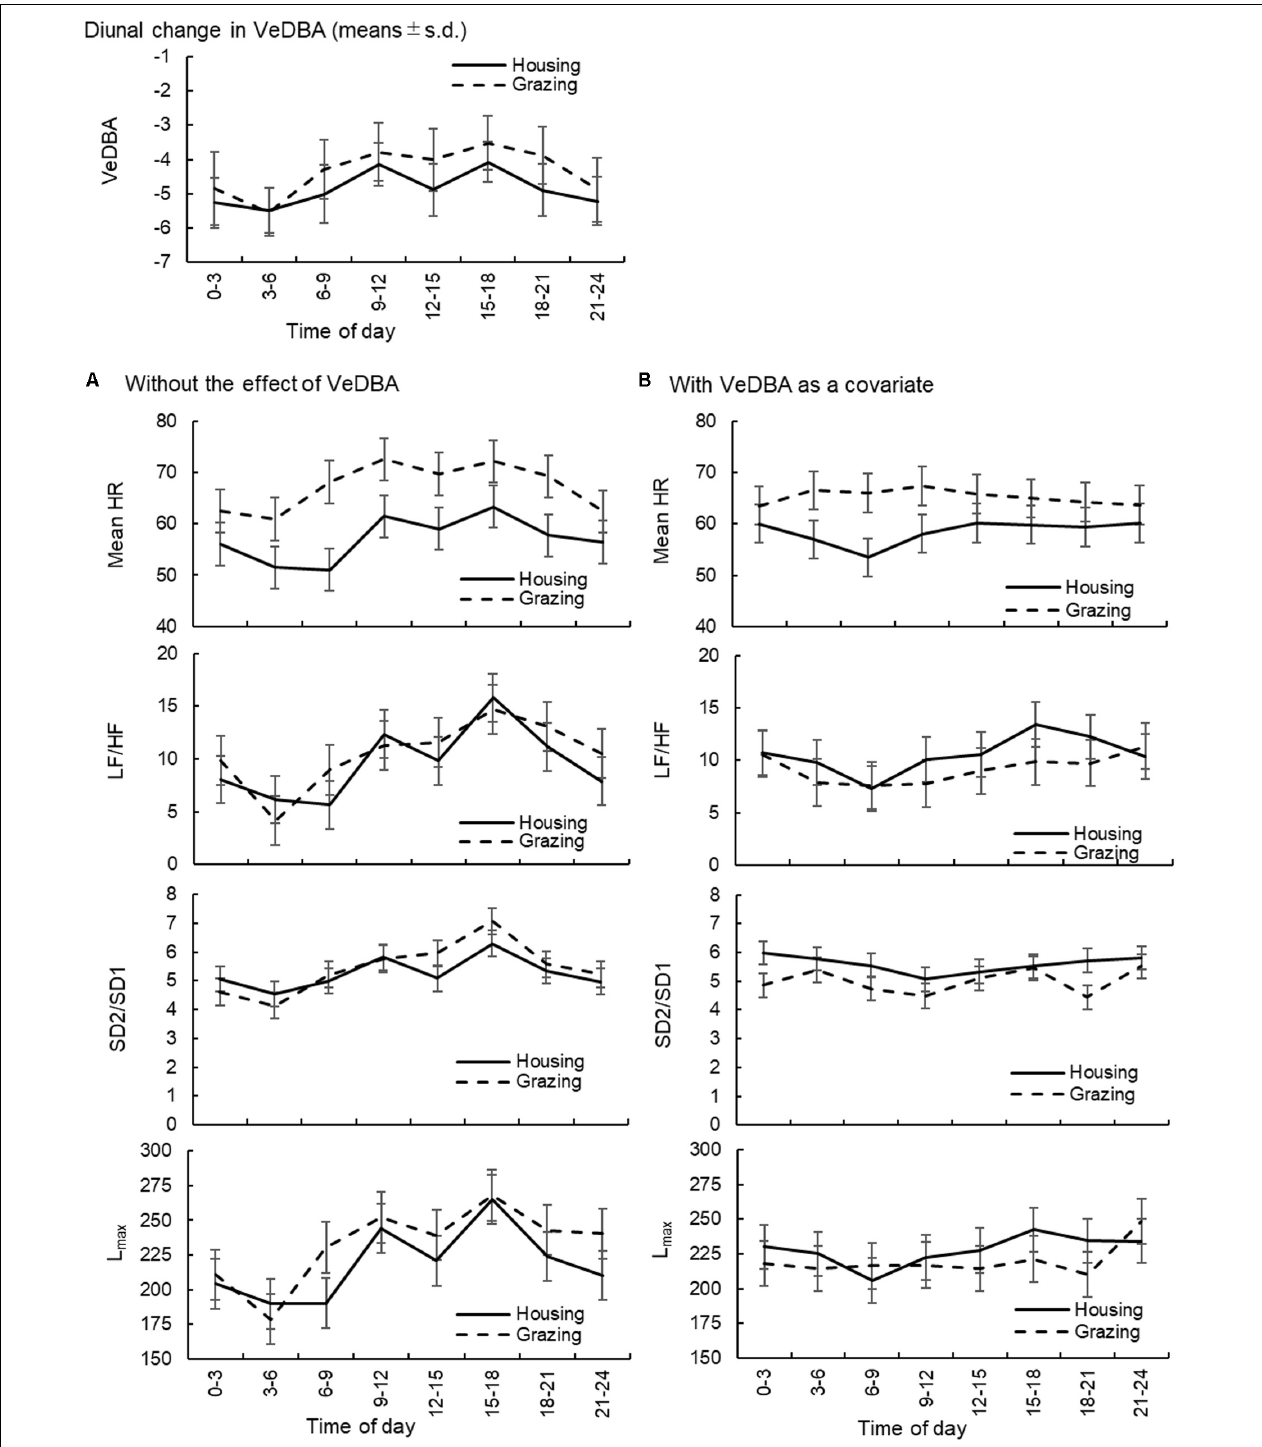
FIGURE 2 | Diurnal changes in VeDBA and the effects of the change in time of day on the mean HR and HRV parameters (LF/HF, SD2/SD1, and L max ) in cattle. (A) The changes in the mean HR and HRV parameters without considering the effect of VeDBA and (B) those when the effect of VeDBA was included as a covariate. The VeDBA plots are presented as arithmetic mean and standard deviations, and plots for the other parameters are presented as least squares mean and standard errors. VeDBA: natural logarithmically transformed vectorial dynamic body acceleration ( g ), HR, heart rate; HRV, heart rate variability; LF/HF, the ratio of normalized power of the low frequency band to the high frequency band; SD2/SD1, the ratio of standard deviation of long-term HRV measured from axis 2 of Poincaré plot to axis 1 in Poincaré plot; L max , the length of longest line of recurrent points (beats).